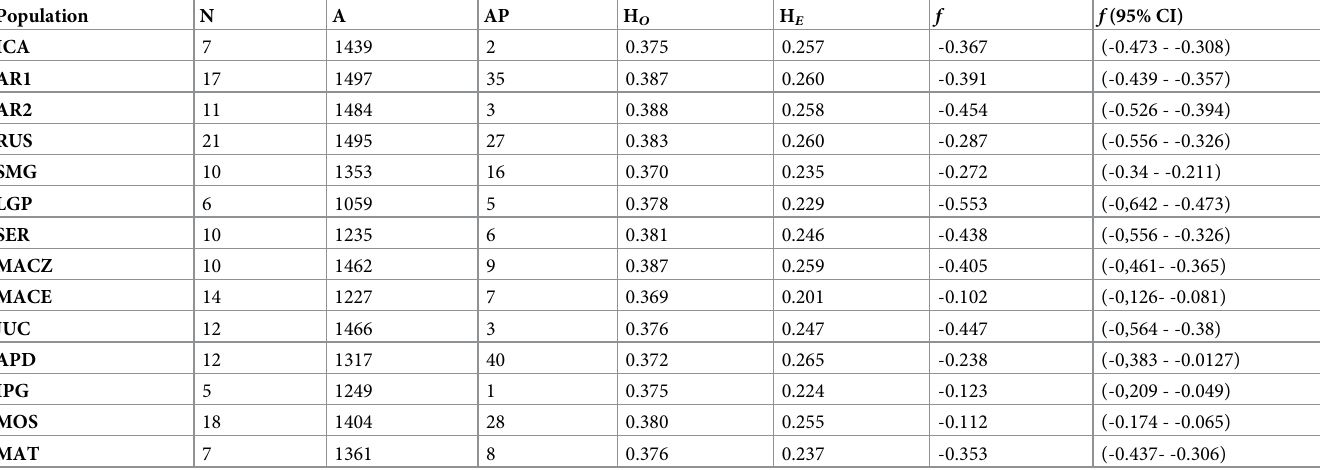
Table 1. Estimates of genomic diversity and inbreeding based on 929 neutral SNP markers for populations of C . prunifera . Population